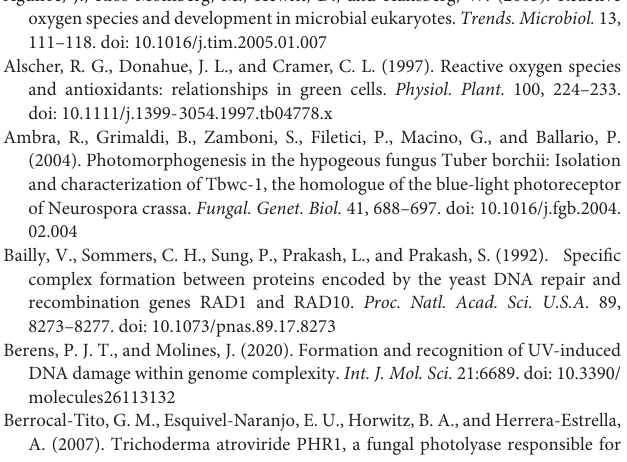
Supplementary Figure 1 | Phylogenetic analysis of ENVOY protein in various filamentous fungi. Phylogenetic relationships of T. atroviride ENVOY with representative fungal counterparts. The NCBI access code of each ENVOY or VIVID protein and its sequence identity are presented in parentheses after each